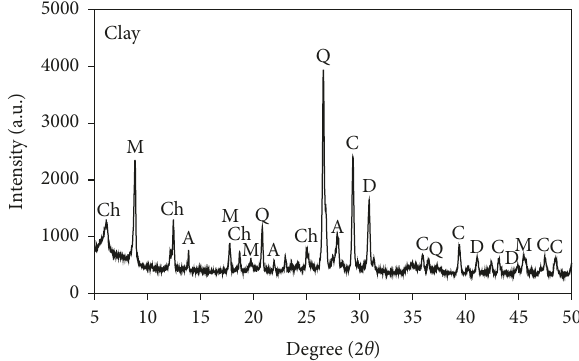
Figure 1: XRD of clay before the firing process. Q: quartz,